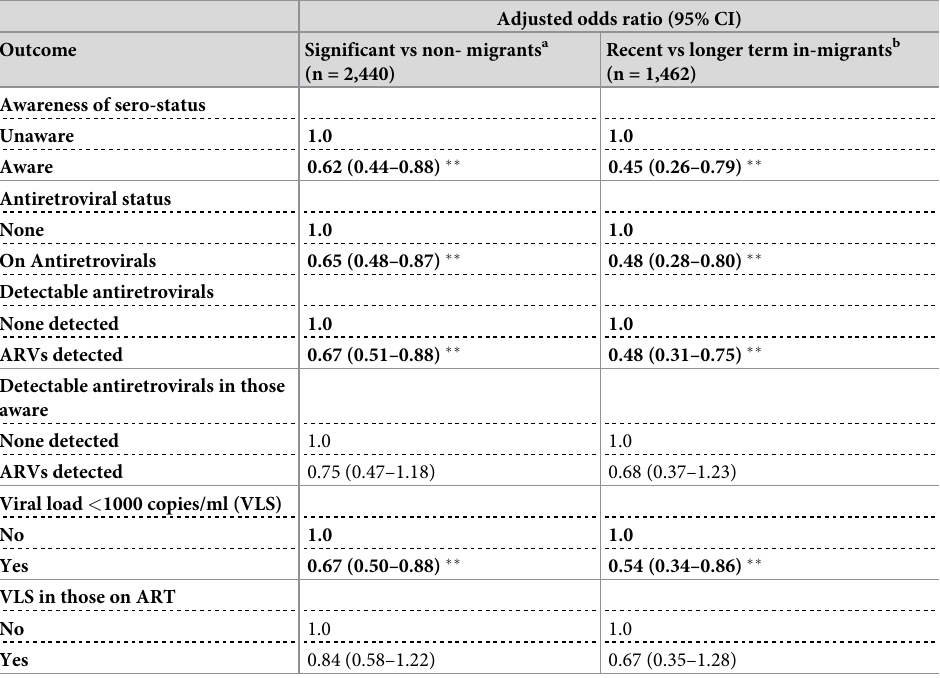
Table 3. Associations between the two indices of migration and the HIV-treatment cascade among people living with HIV in the 2017 Namibia Population-based HIV Impact Assessment